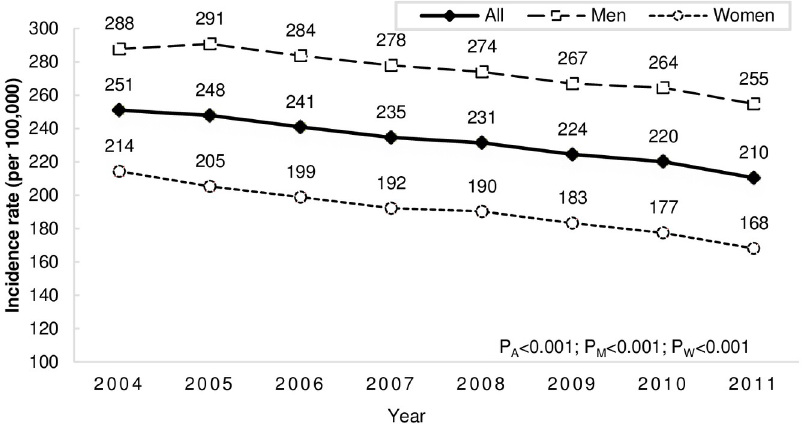
Fig 1. Trends of age-adjusted incidence of all first-ever strokes. P All = p for trend in all strokes; P M = p for trend in men; P W = p for trend in women.